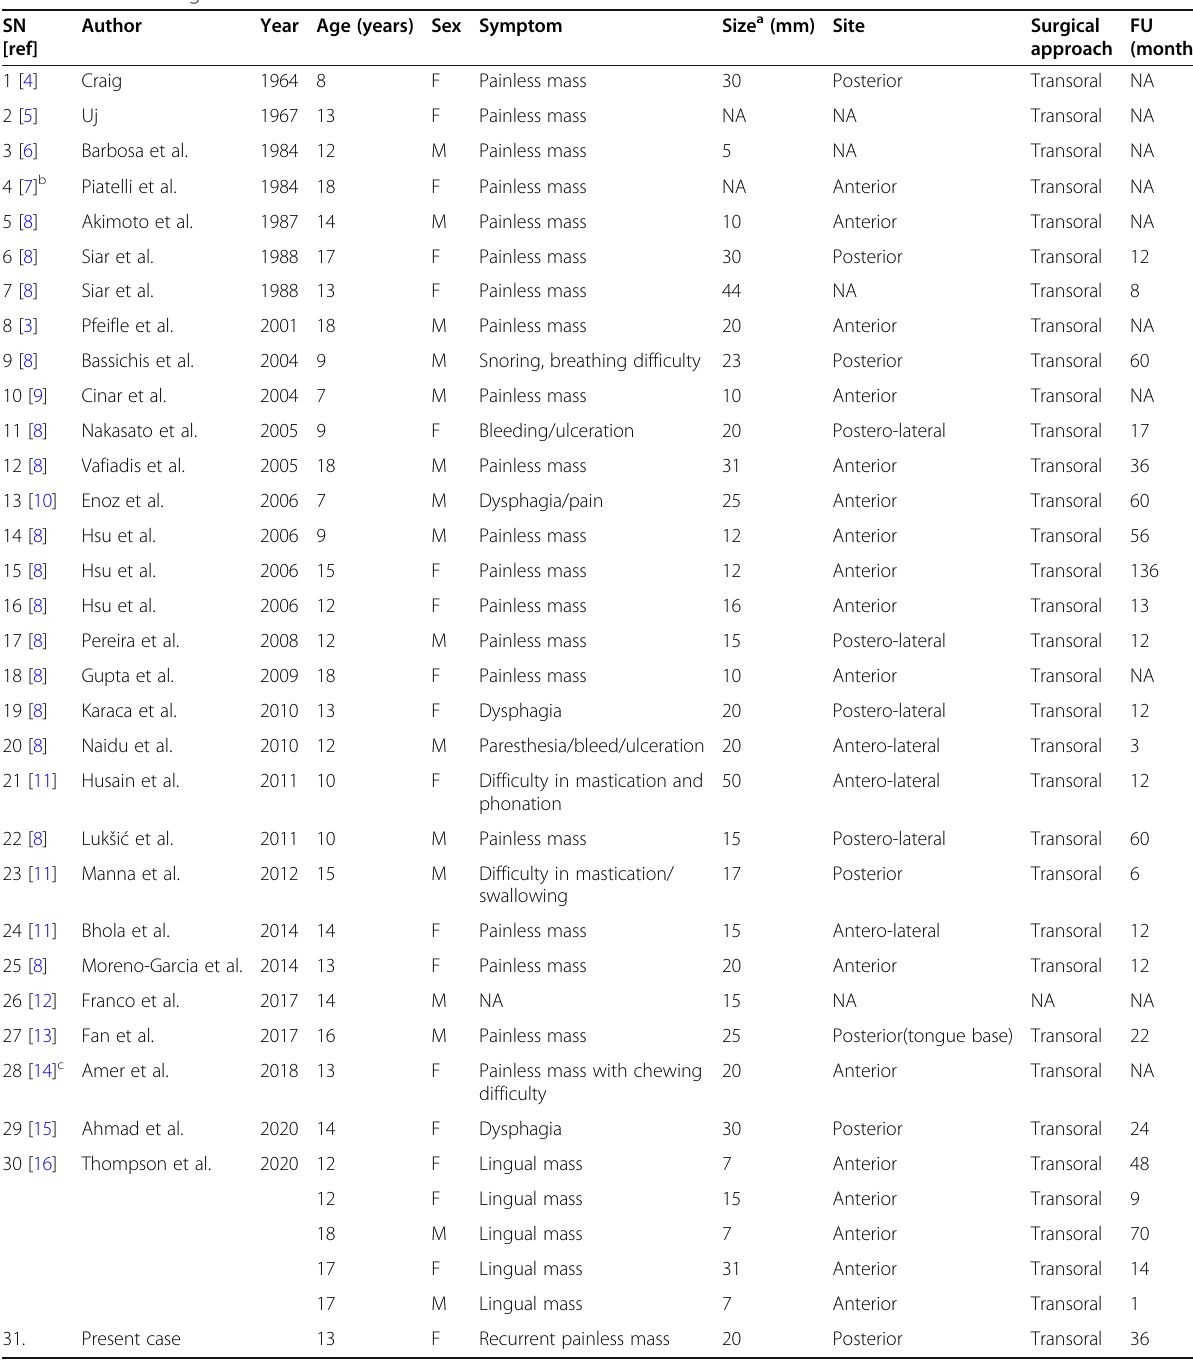
Table 1 Pediatric lingual schwannomas — review of